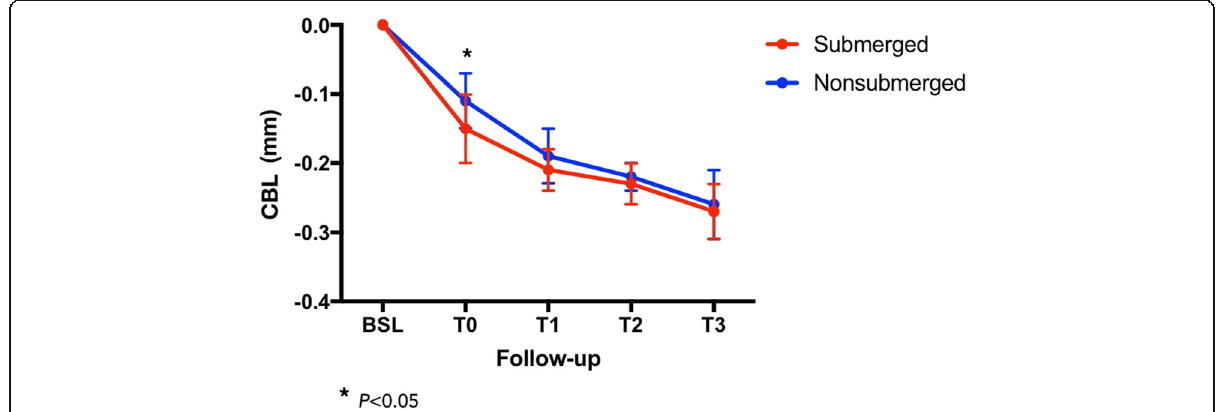
Fig. 8 Mean values of crestal bone loss (CBL) between the two groups during the follow-up period. ANOVA